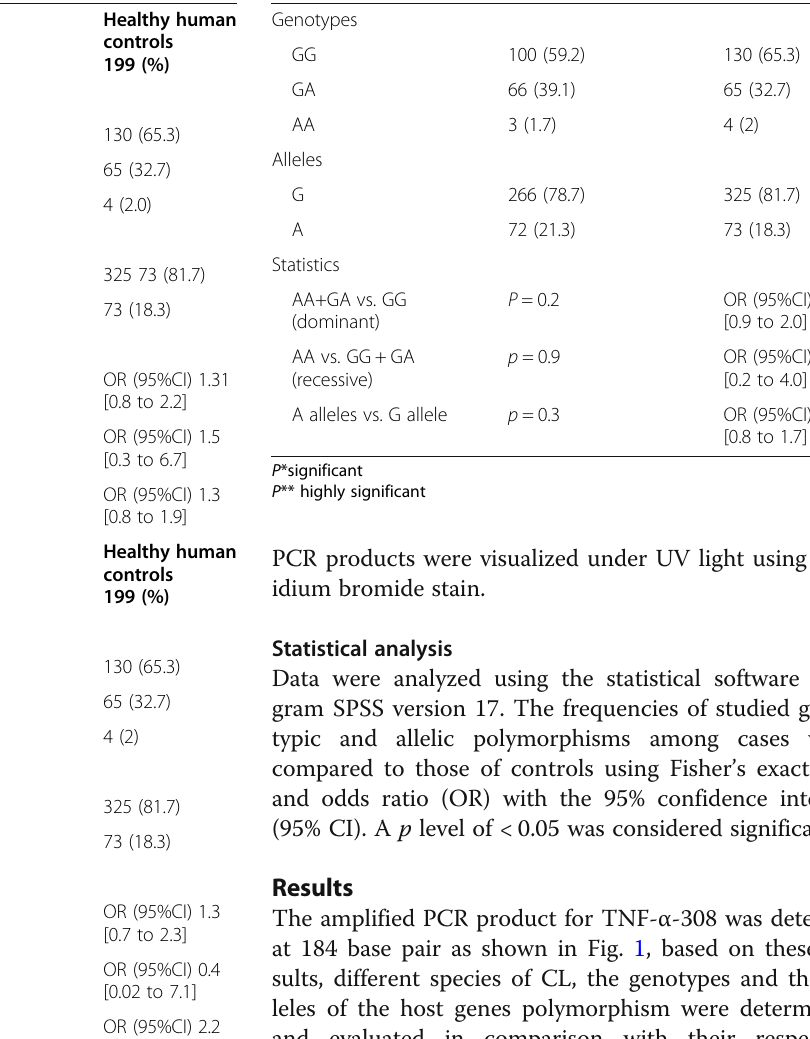
Table 3 Genotype frequencies of TNF- α -308 G/A in different species of leishmaniasis and healthy human controls